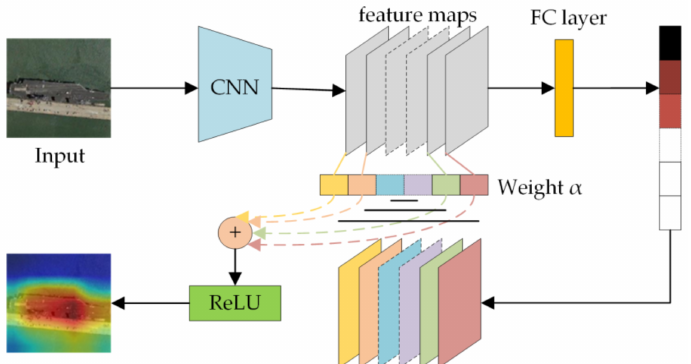
Figure 5. The class activation map of ship is obtained through Grad-CAM. Grad-CAM finds the gradient of the last layer of the convolutional layer, and the average value of the gradient is the weight of the feature map. Then, calculate the weighted sum to get the class activation